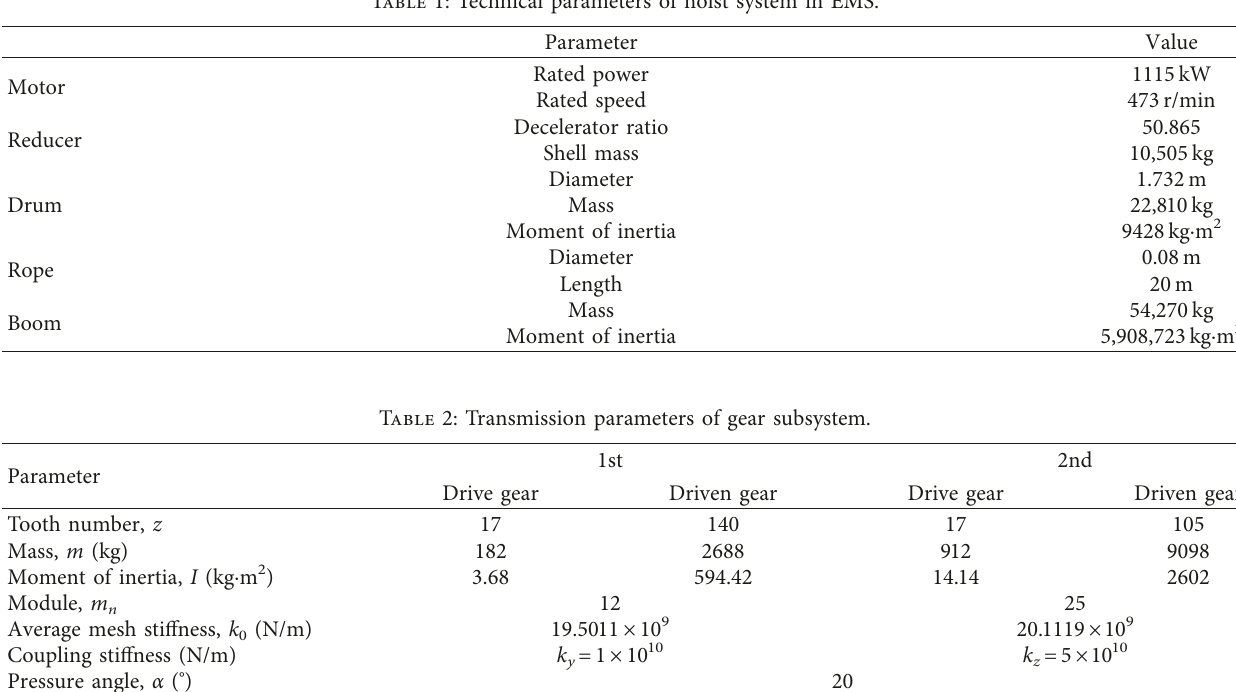
Table 3: Coupling stiffness of hoist system in EMS.